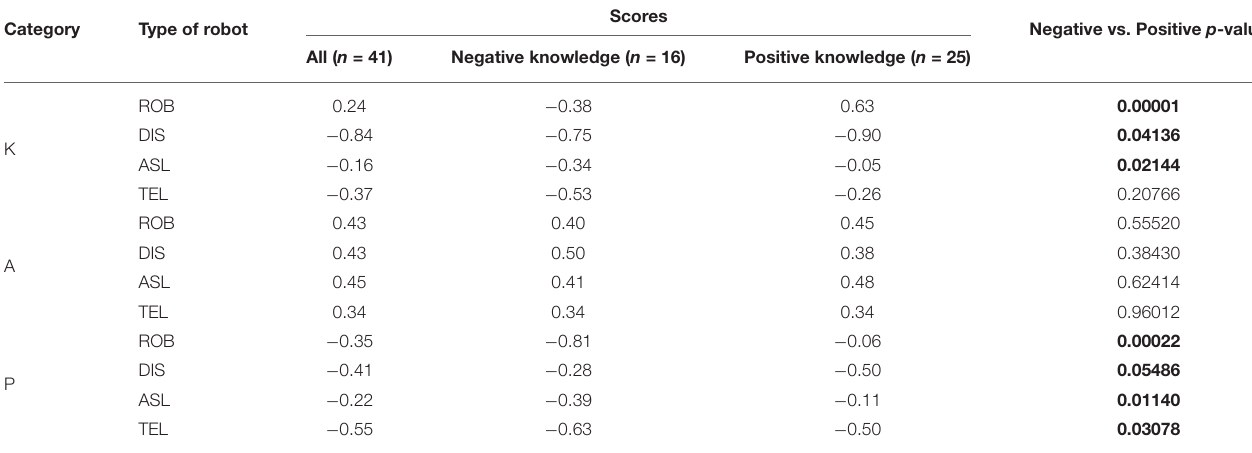
TABLE 7 | Comparison of average scores obtained for the participants with a negative knowledge about robotics (ROB) and the participants with a positive knowledge about robotics (ROB).